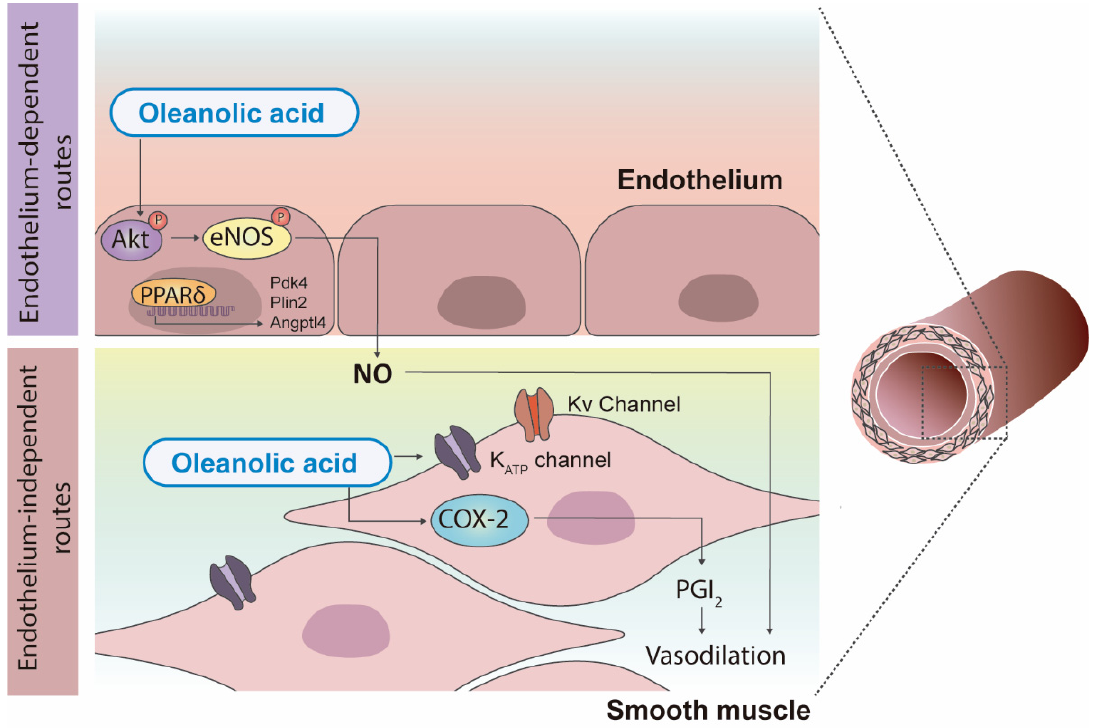
Figure 4. Main mechanisms involved in the beneficial vascular effects of triterpenic acids. Vasodilation evoked by oleanolic acid implies endothelium-dependent and independent pathways. In the endothelium, oleanolic acid induces PI3K-dependent phosphorylation of Akt-Ser (473) followed by phosphorylation of eNOS-Ser (1177) with subsequent release of nitric oxide (NO) and PPAR δ activation. In the vascular smooth muscle, oleanolic acid leads to vasodilation throughout activation of ATP-dependent and voltage-activated K + channels and by induction of prostacyclin (PGI 2 ) release after COX-2 activation. P, phosphorylation; eNOS, endothelial NO synthase; PPAR δ , peroxisome proliferator-activated receptor delta; Pdk4, pyruvate dehydrogenase kinase 4; Plin2, perilipin 2; Angptl4, angiopoietin like 4; Kv, voltage-gated potassium channel; K ATP , adenosine 5’-triphosphate (ATP)-sensitive potassium; COX-2, cyclooxygenase-2; Ser, serine.